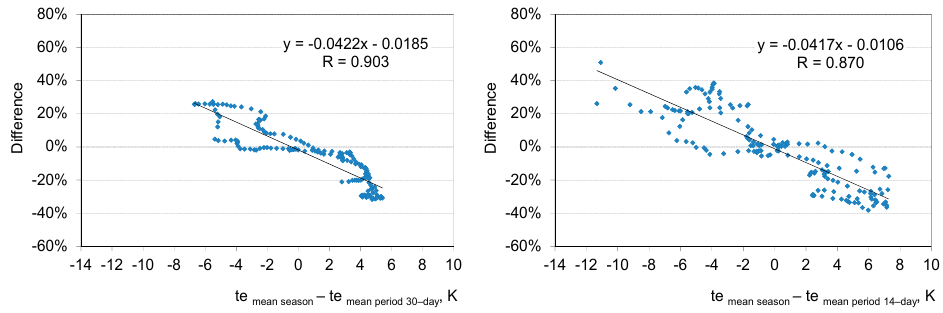
Figure 10. Correlation between seasonal heat demand difference in the school building, used all week, and the external temperature difference (mean for the season and mean for each short period) for the 30-day measured periods (on the left) and for the 14-day measured periods (on the right); only for periods with R ≥ 0.6.